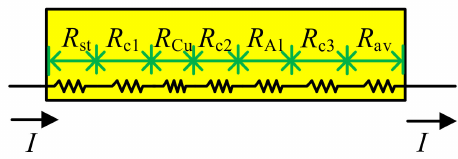
Figure 2. Schematic of the resistances in the RUSW